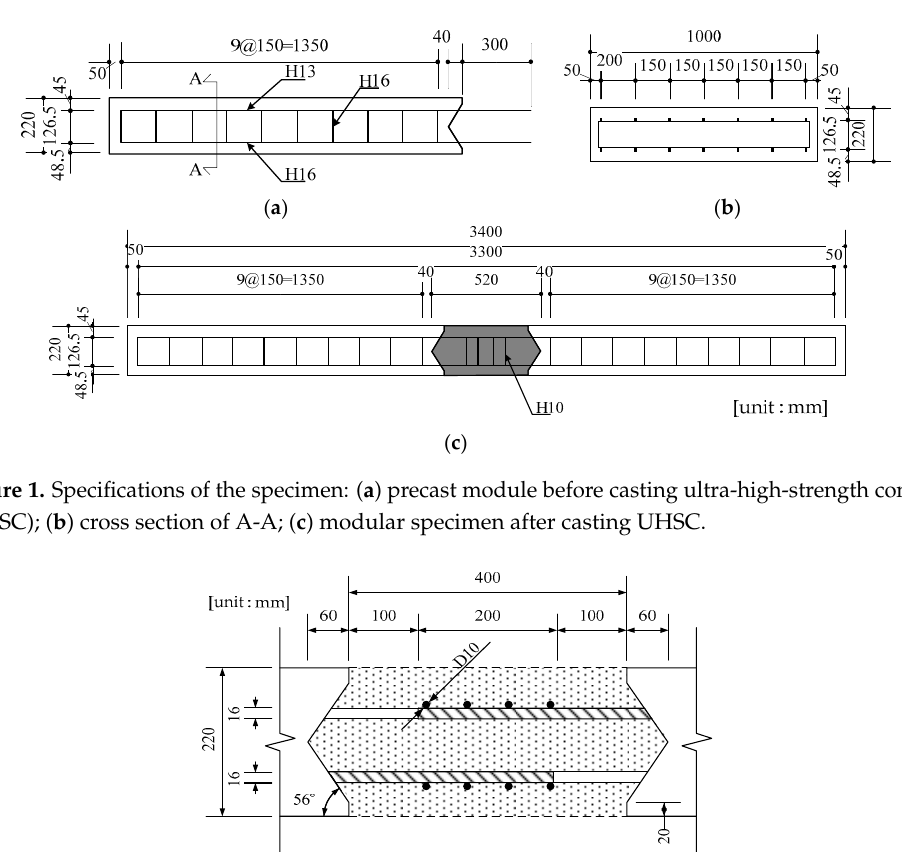
Figure 2. Specifications of the joint.